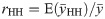
For the simulated population, bias index of the Hansen & Hurwitz estimator as a function of the nonresponse rate at the last phase.Curve of the bias index rHH=E(y¯HH)/y¯ based on 1000 simulations of the nonresponse mechanism, for πz = 0.2, πm(1) = 0.85, and πm(2) = 0(0.1)0.9. Details in the text.